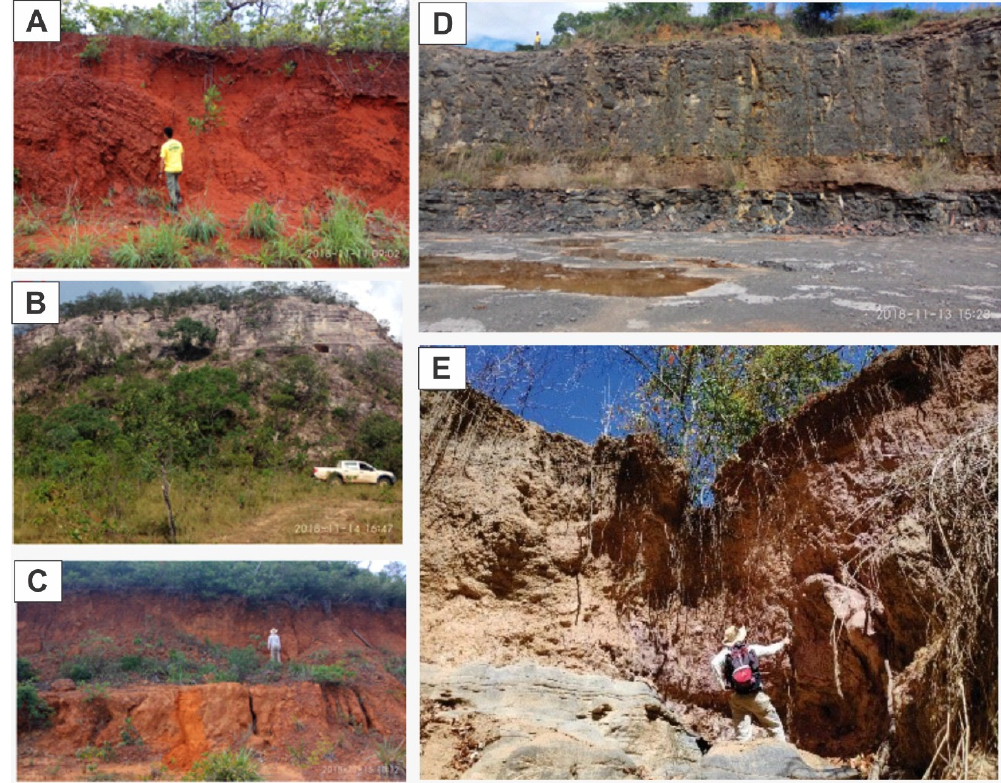
Figure 3. Photographs of different soil and rock units exposed in the area. ( A ) Ferrosols and Serra das Araras Formation. ( B ) Arenosols from Posse Formation. ( C ) Cambisols from Areal group. ( D ) Outcrop showing limestone and claystone transition. ( E ) Chernozem on top of limestone outcrop from Lagoa do Jacaré formation.